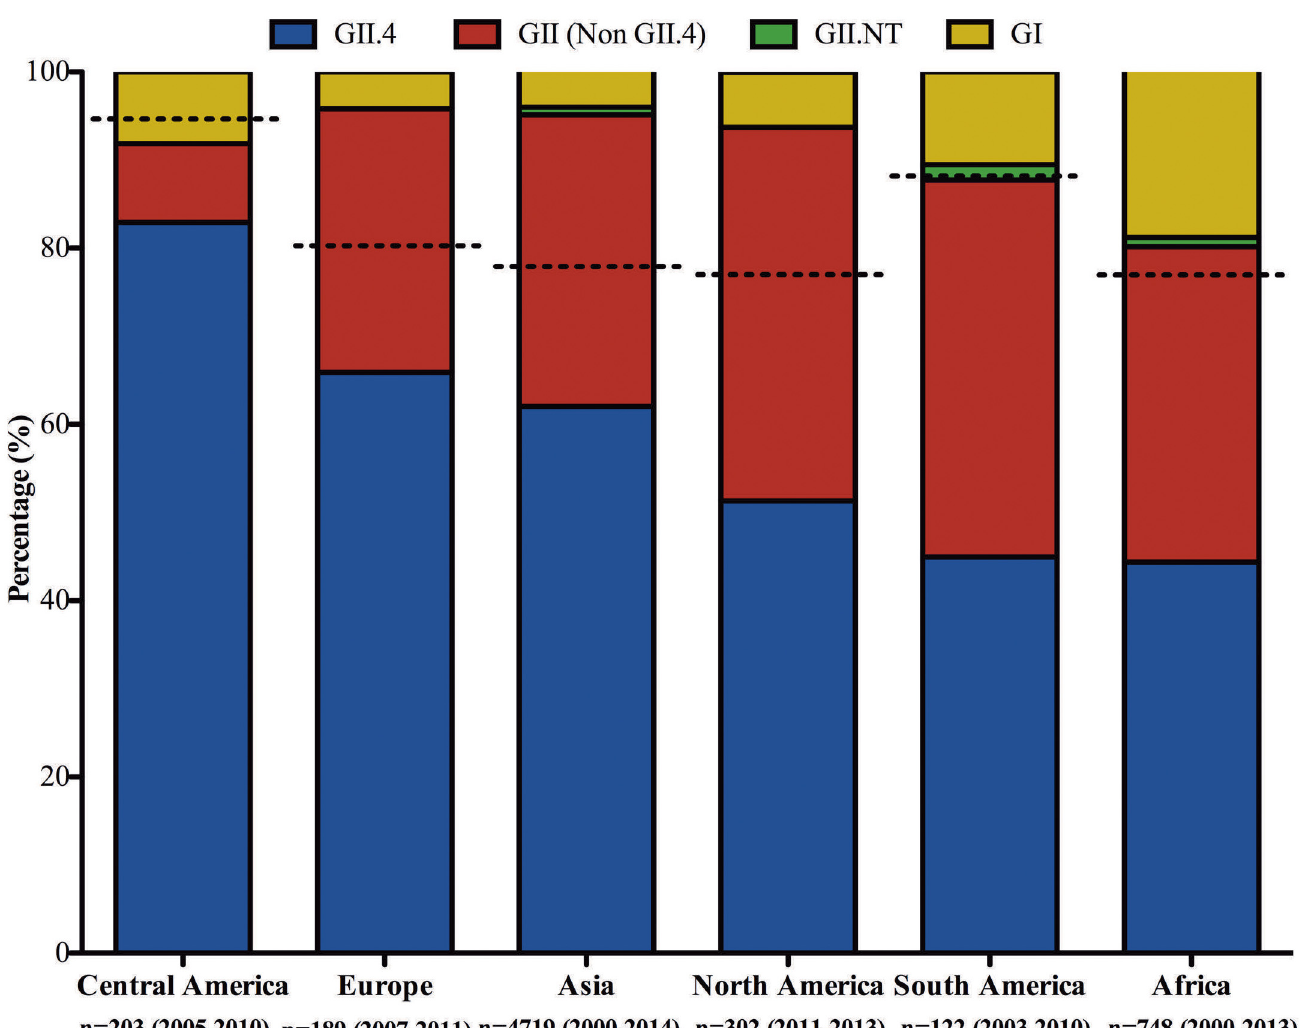
Fig 1. GII.4 detection rates worldwide among norovirus-positive children with sporadic acute gastroenteritis. Data were collected from 53 studies conducted in 31 different countries among children with sporadic acute gastroenteritis. Studies with samples collected after the year 2000 with sample collection done for a minimum of one year and based on genotyping of the capsid region are included. Due to lack of sufficient available data from Africa, studies conducted for less than one year have also been included for this region. The data shown are from a total of 6,283 genotyped samples from 28 different studies from Asia, 13 from Africa, five from South America, one from North America, and three each from Europe and Central America (S1 Table). The number (n) in the figure represents the number of genotyped samples, while the duration of sample collection for each region is mentioned within the parentheses. GII.NT represent non-typeables. Broken lines represent approximate percentages of secretors in the